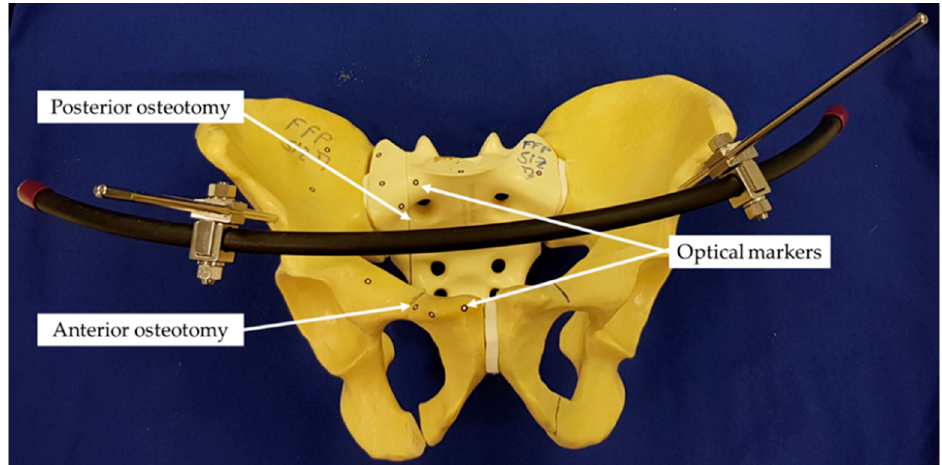
Figure 2. Anterior view of a specimen prepared for biomechanical testing with anterior and posterior osteotomies simulating an unstable pelvic ring fracture and equipped with optical markers for motion tracking. The anterior pelvic ring was addressed with a supra-acetabular external fixator. An anterior pelvic ring fracture was created via transverse cuts of the superior and inferior ramus of the pubis, set 2 cm laterally to the pubic tubercle. A posterior pelvic ring